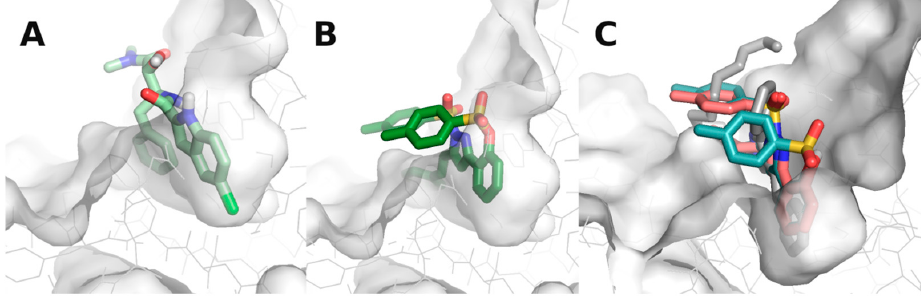
Figure 4. Styrylpyrazoles in GPa’s inhibitor binding site . ( A ) CP-91149 (pale green) in the inhibitor binding site. ( B ) Compound 14 (dark green) in the inhibitor binding site. ( C ) Compounds 6 (grey), 13 (salmon), and 15 (light teal).